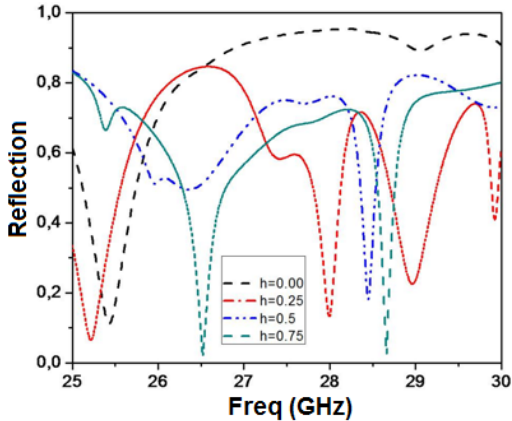
Figure 3: The dependence of absorption frequency on the distance h .